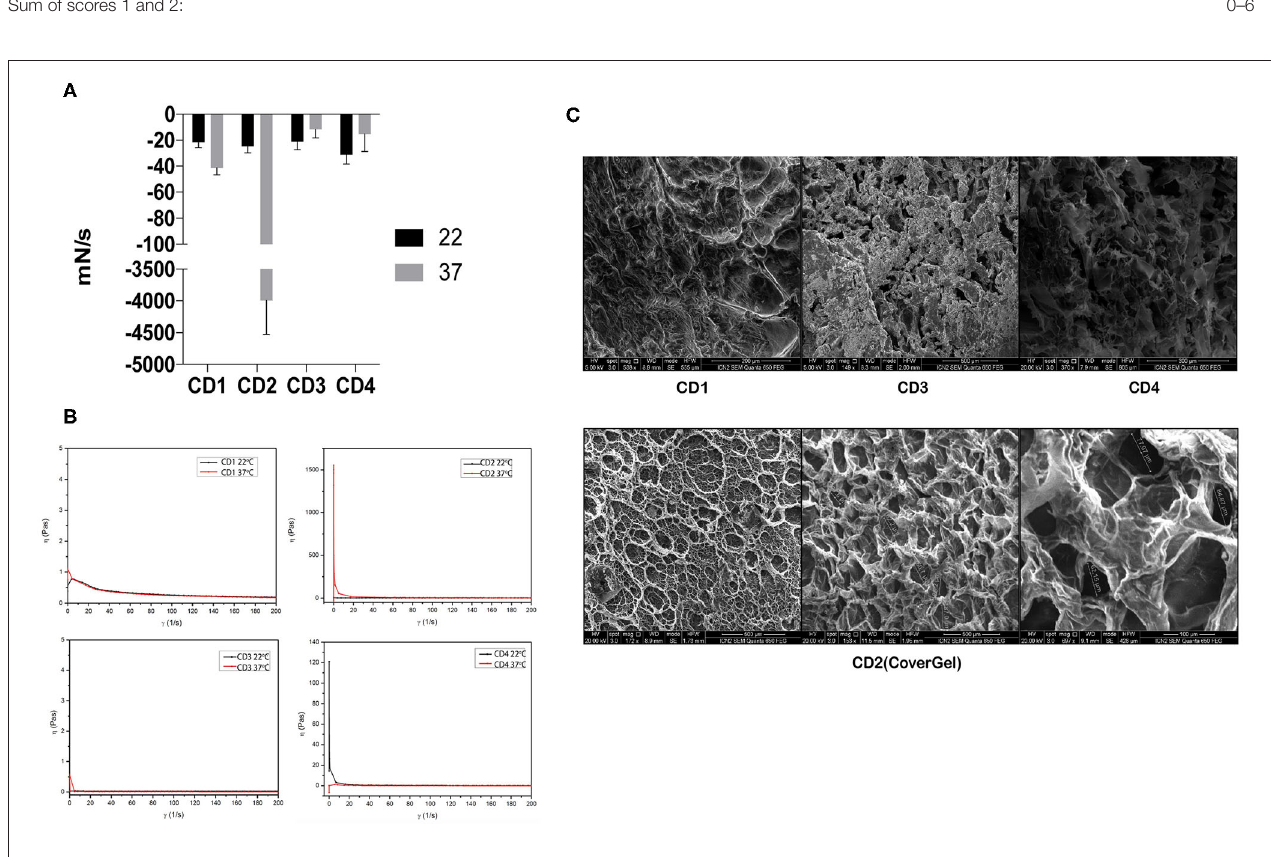
FIGURE 1 | Rheological evaluations of the four original colon dressings (CDs). (A) Adhesion force evaluated at 22 ◦ C and 37 ◦ C expressed in mN/s. (B) Viscosity evaluated at 22 ◦ C (black line) and 37 ◦ C (red line) expressed in pascals. (C) Scanning electron microscopy images of CD1, CD3, and CD4 (top three pictures) and CD2 (bottom